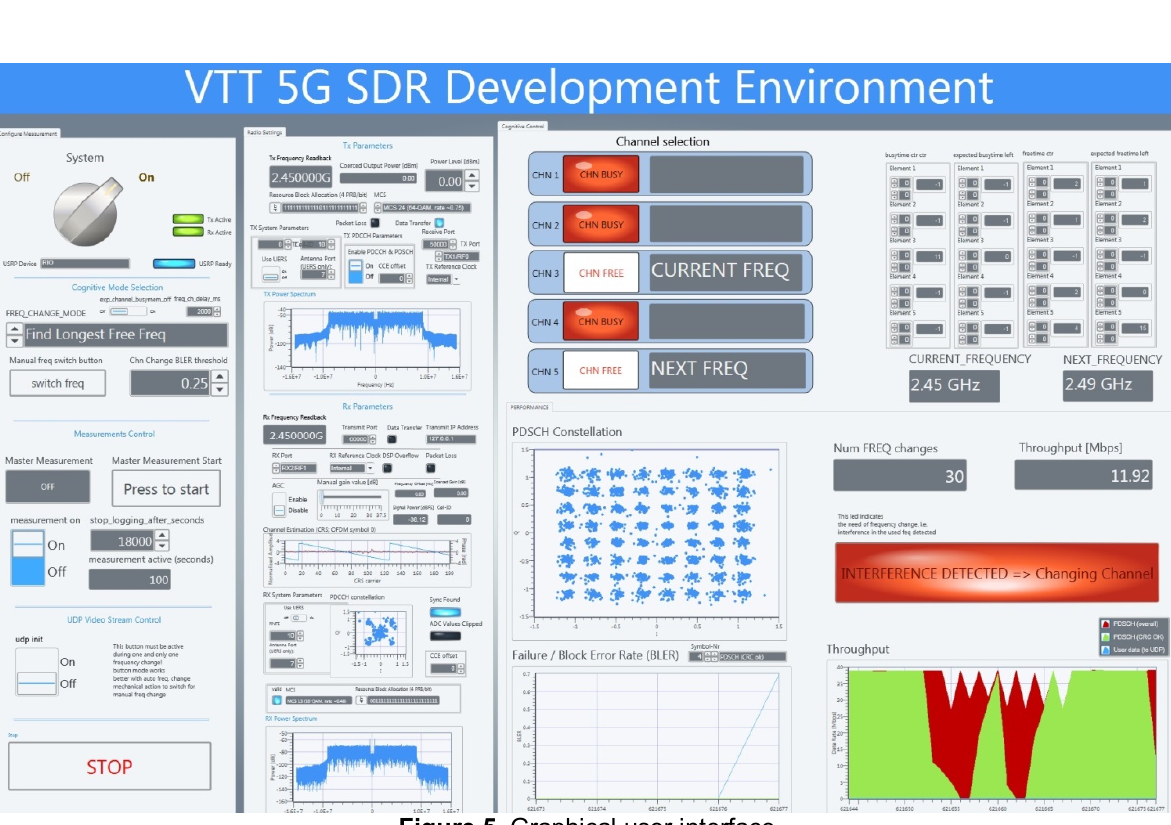
Figure 5. Graphical user interface